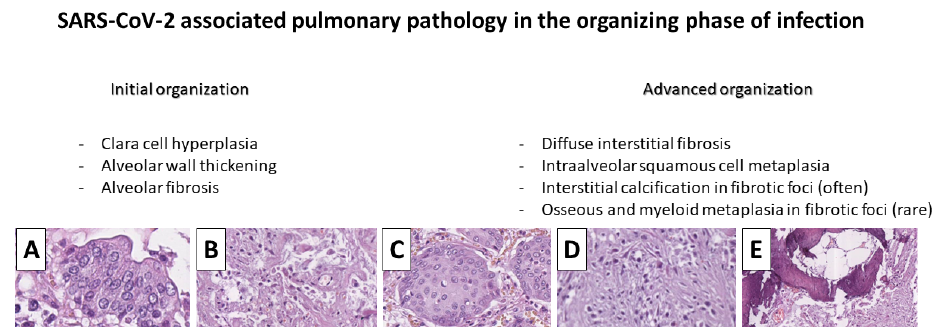
Figure 3. Organizational changes in COVID-19: ( A ) Clara cell hyperplasia in alveolar tracts and alveoli; ( B ) fibrosis with thickening of the alveolar septa; ( C ) intra-alveolar squamous cell metaplasia; ( D ) diffuse fibrosis; ( E ) osteoid and myeloid metaplasia in fibrotic foci. Note: Histology sections adapted from ref. [60].